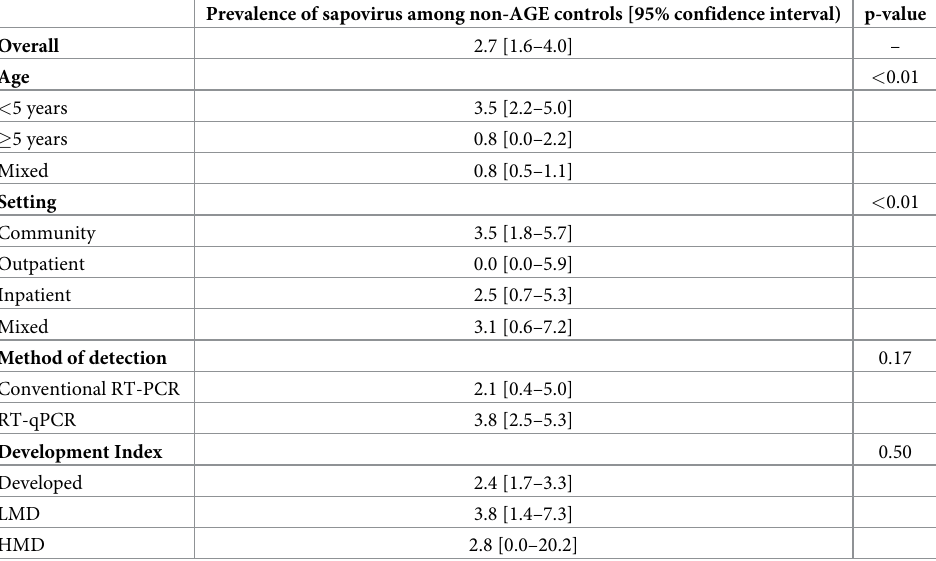
Table 3. Prevalence of sapovirus among non-AGE controls, overall and stratified by setting, method of detection, and development